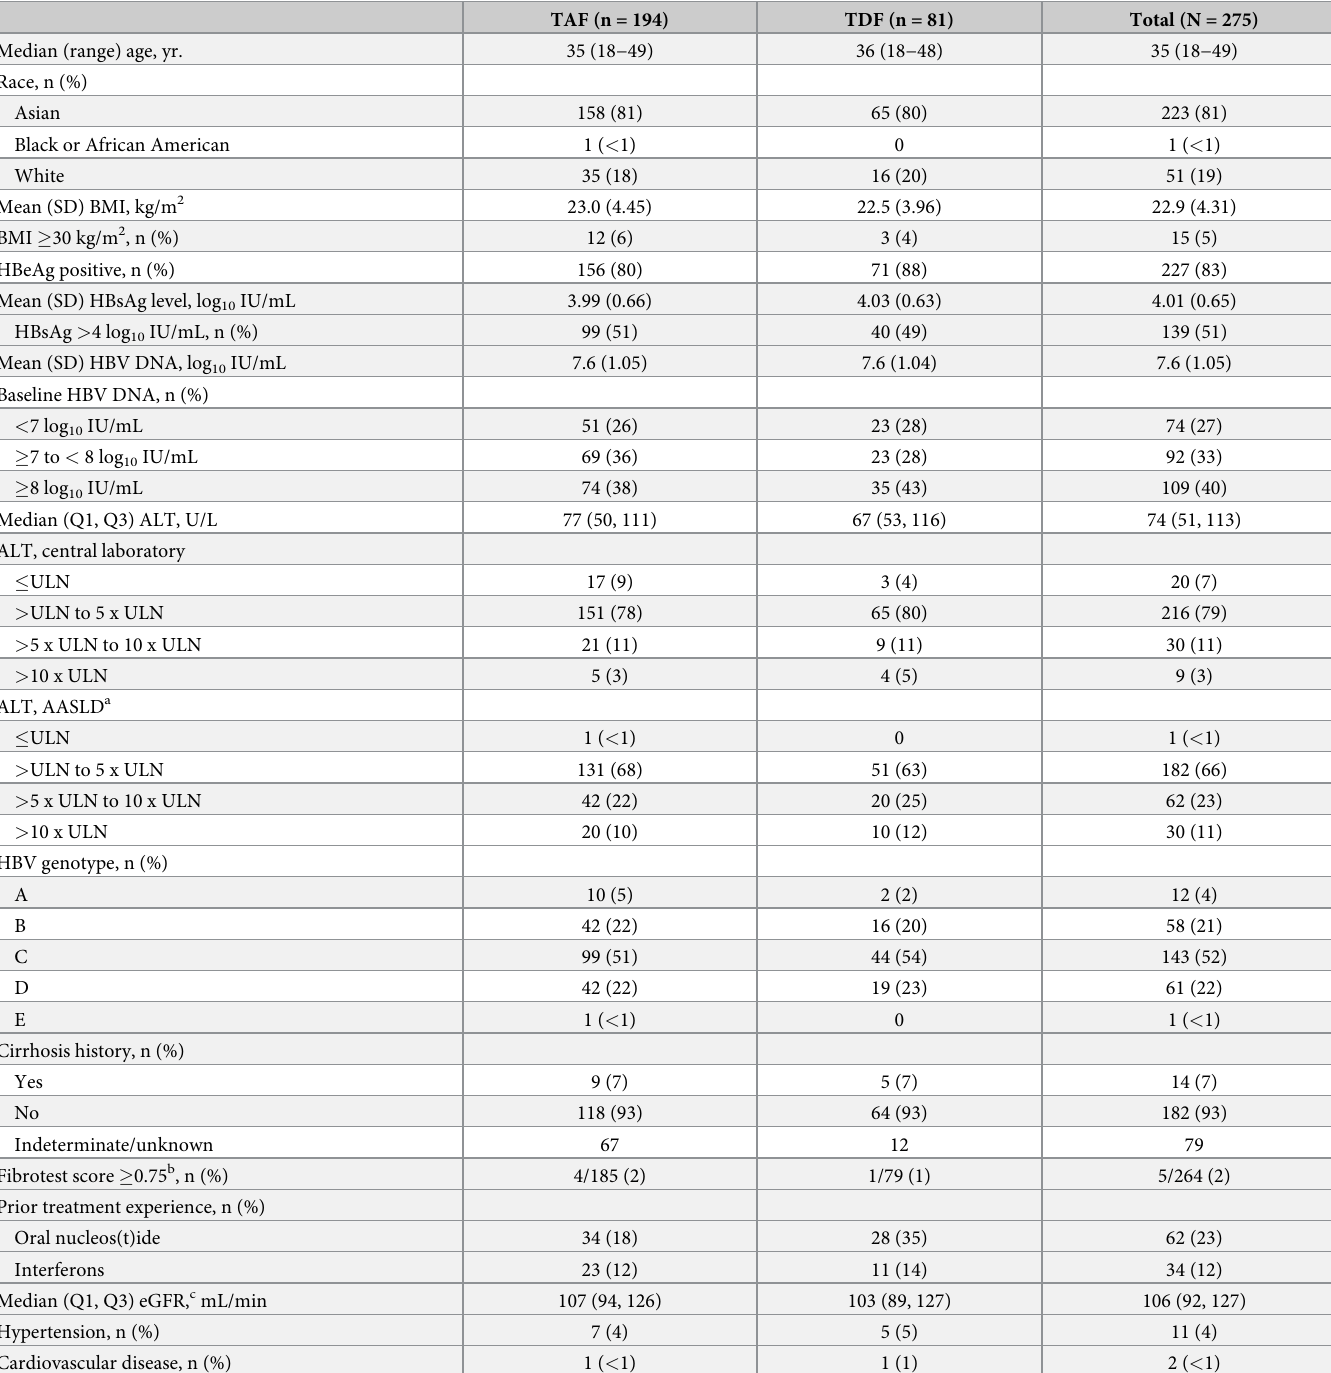
Table 1. Patient demographics and baseline characteristics in the subset of WOCBP (studies GS-US-320-0110 and GS-US-320-0108; week 96 integrated safety anal- ysis set; reference 21). TAF (n = 194) TDF (n = 81) Total (N = 275) Median (range) age,